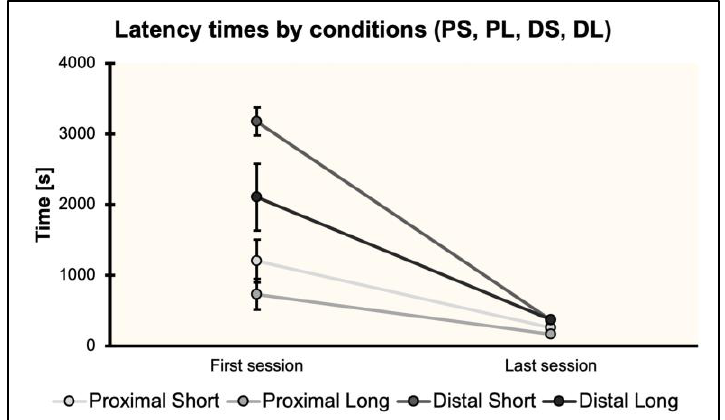
Figure 6. Latency times before leaving the arena through a correct choice, in the four experimental conditions (PS, PL, DS, DL) separately.